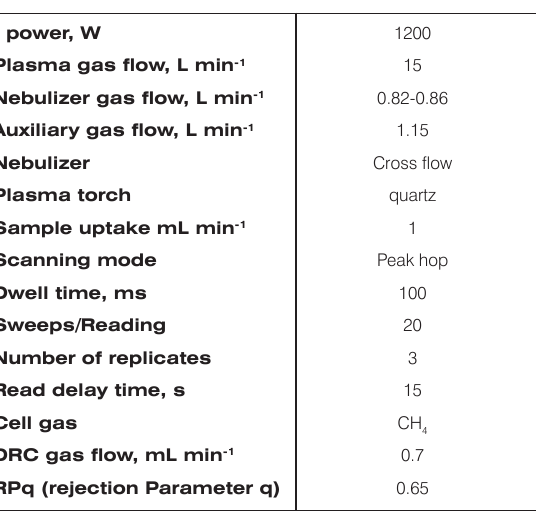
Table 1. Measurement conditions for ICP-MS (Perkin-Elmer Sciex ELAN 6100).